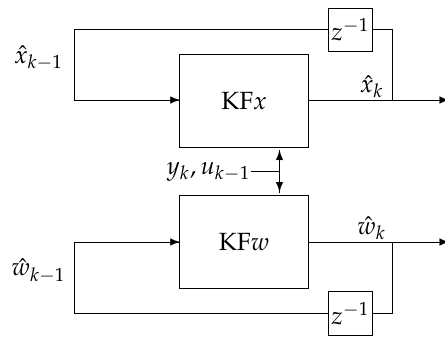
Figure 1. Dual estimation scheme.